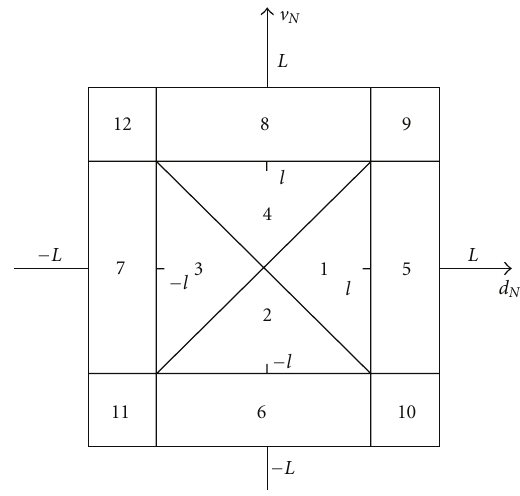
Figure 5: Regions of normalized input